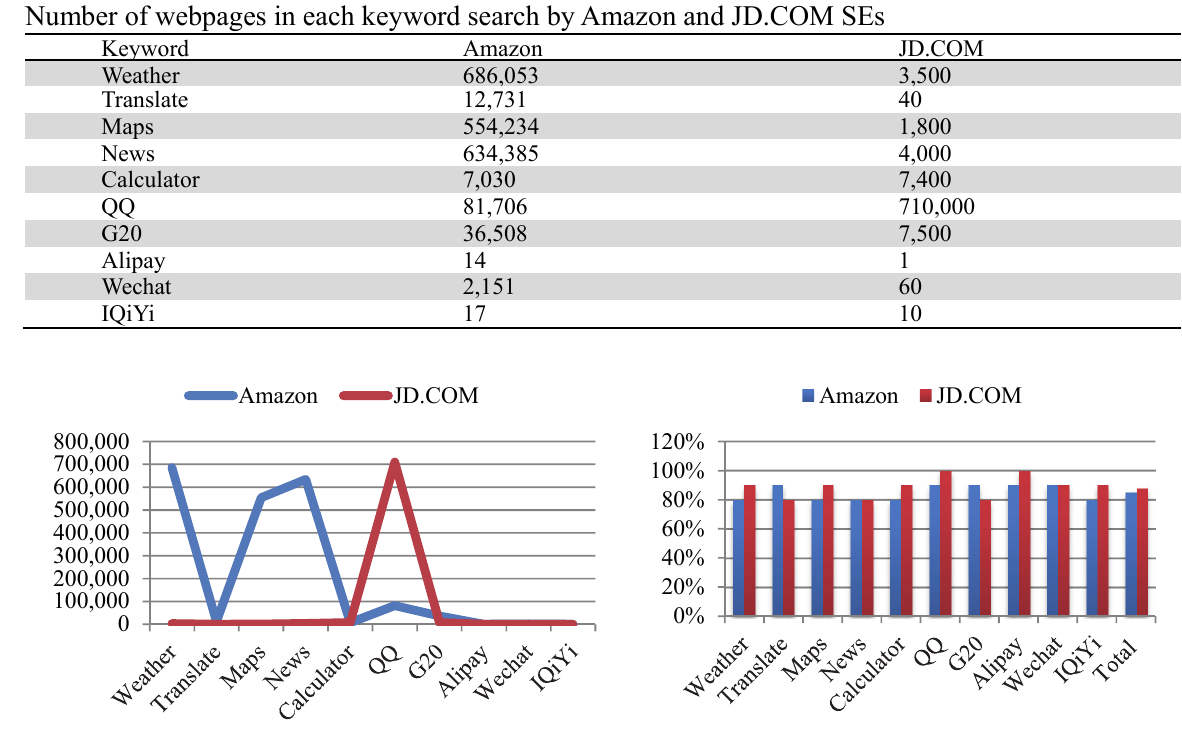
Fig. 8. Comparison of Number of webpages in each Fig. 9. Comparison of Precision in Ama-